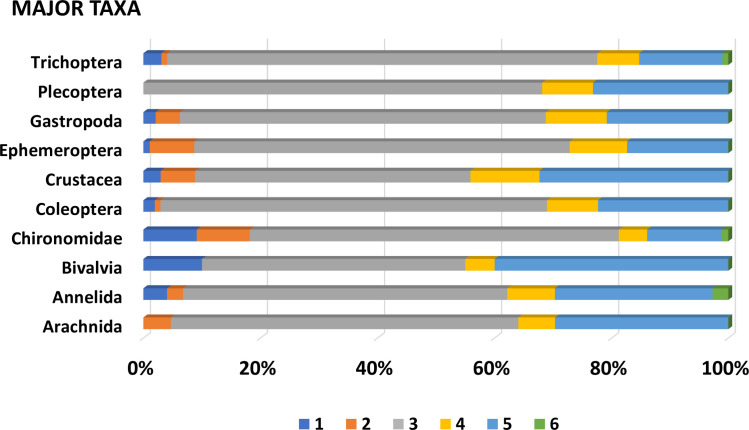
Percentages of taxa in “major” benthic macroinvertebrate groups in six uncertainty/frequency classes.1, high confidence, common; 2, high confidence, moderately common; 3, high confidence, rare; 4, moderate confidence, rare; 5, low confidence, rare; 6, outliers, mixed.